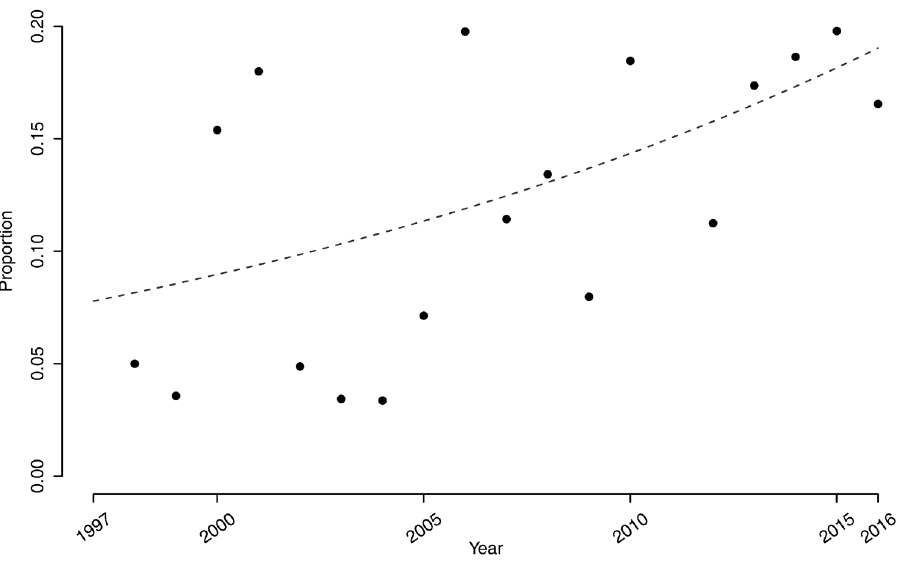
Figure 3. The proportion of poorly trimmed (y-axis) fungal ITS sequences submitted to the INSDC does not decrease over time (x-axis). The regression line (dashed), which was derived by overdispersed Poisson rate regression, shows a weak but significant increasing trend (yearly relative increase of 0.047,